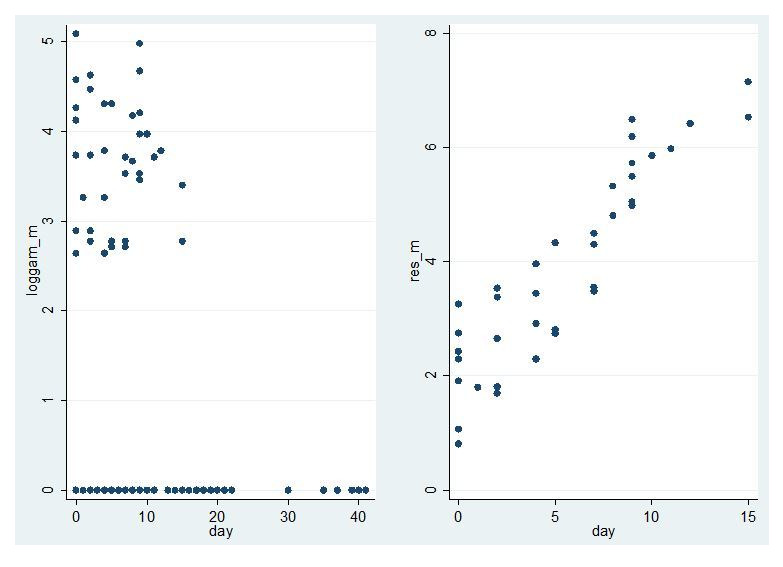
Model fit for CHMI-trans data male gametocytes.Log male gametocyte densities at different days of follow-up (left) and residuals of non-zero male log gametocyte densities as a function of time of follow-up (right).